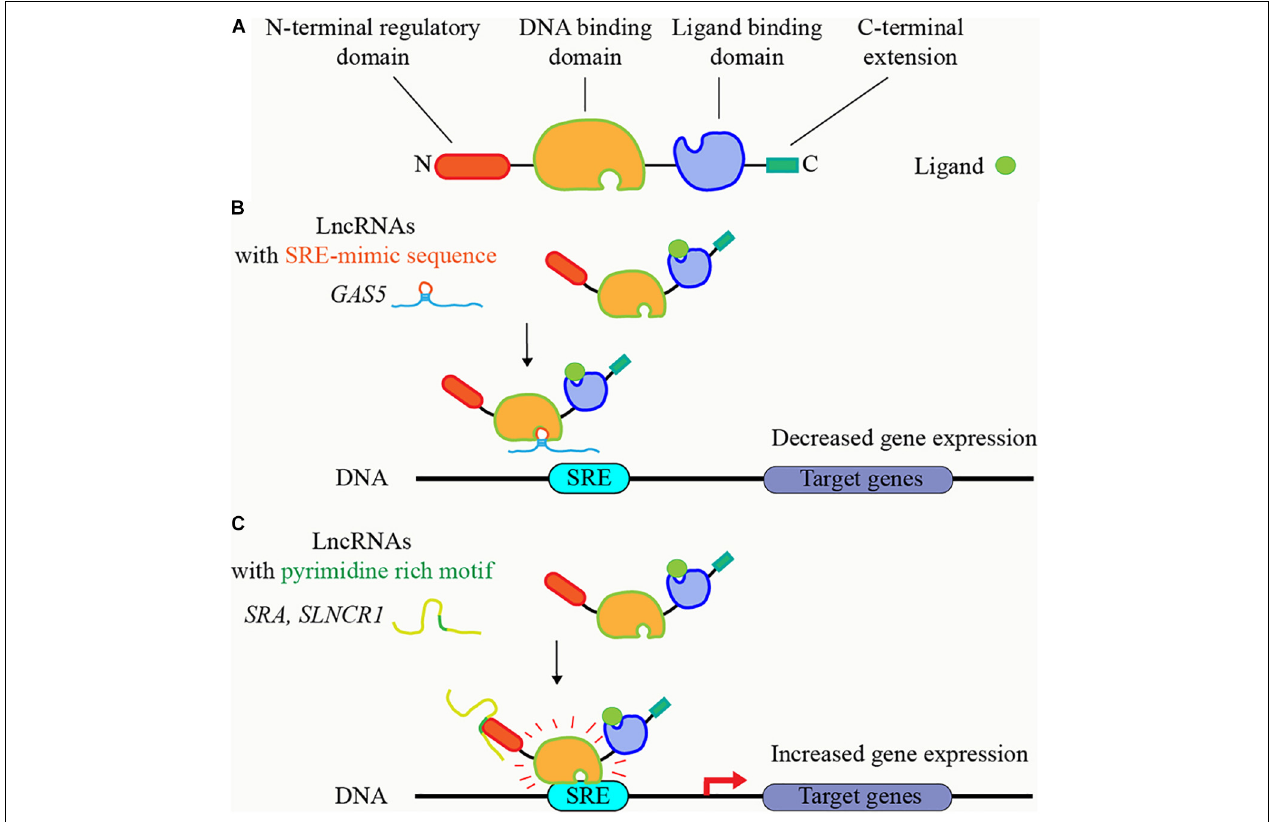
FIGURE 3 | LncRNAs bind to steroid receptors and regulate their activities. (A) Principal functional domains of steroid receptors. The steroid receptors have N-terminal regulatory domain, central DNA binding domain, ligand-binding domain, and C-terminal extension. (B) LncRNAs containing steroid receptor responsive element (SRE) mimic RNA sequence, such as GAS5 , block the binding of steroid receptors to SRE DNA sequence, and suppress steroid receptors’ transcriptional activity. (C) LncRNAs containing short, pyrimidine-rich RNA motif, such as SRA and SLNCR1 , bind to steroid receptors at N-terminal, regulatory domain, and increase steroid receptors’ transcriptional